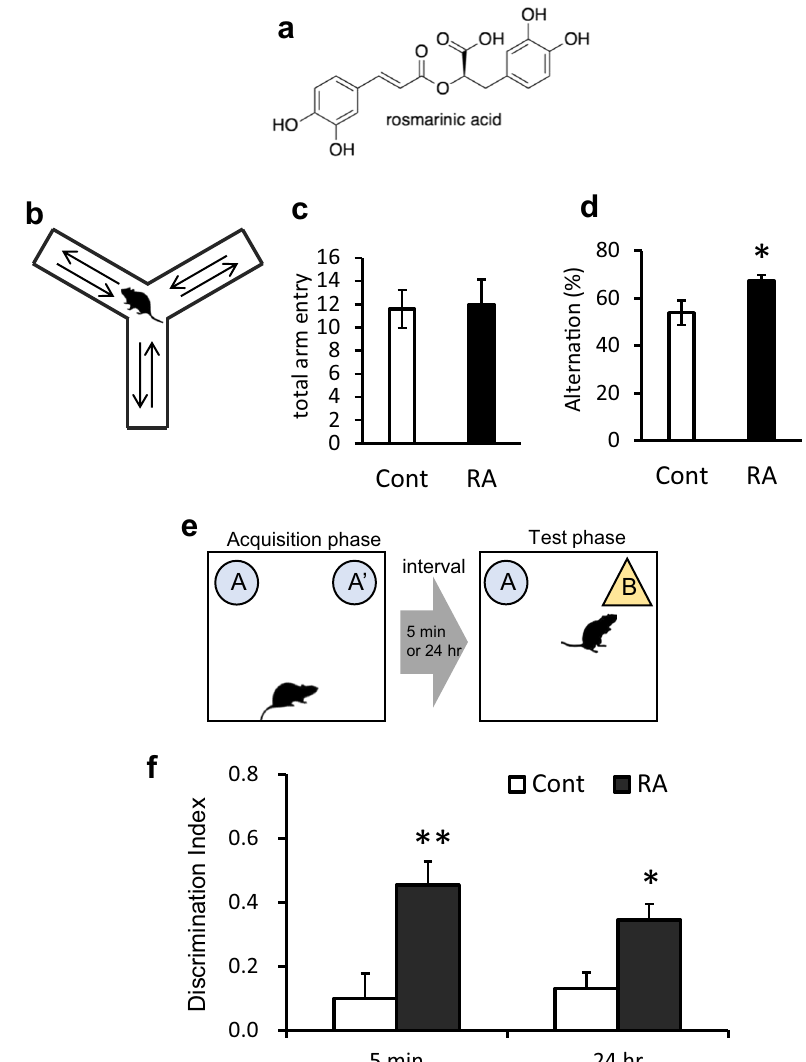
Fig. 1 RA improve cognitive function in 3 × Tg-AD mice. a The structure of rosmarinic acid (RA). b – d Spatial memory is improved by feeding with an RA-supplemented diet. b Y-maze test scheme. c The number of arm entries are similar in both groups. d The spatial memory is lower in the control (Cont) group. e – f Memory for objects is improved in mice fed an RA-supplemented diet. e Acquisition and test scheme for novel object recognition test (NORT). f NORT suggests RA improved cognitive function for object recognition. Data are shown as means ± standard error. Cont, n = 8; RA, n = 9, * p < 0.05, ** p <